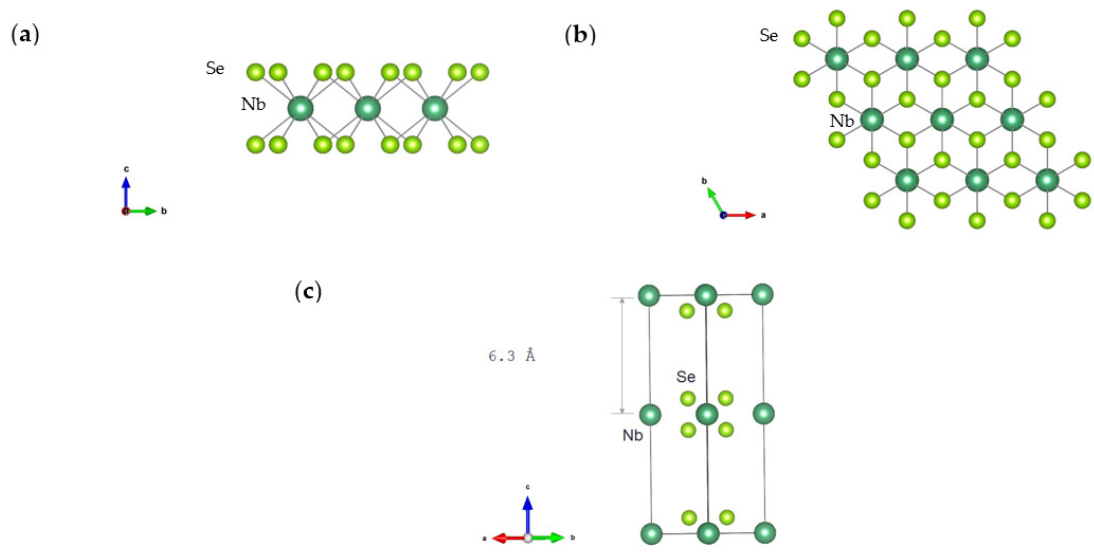
Figure 1. The crystal structure of NbSe 2 in ( a ) Front view, ( b ) Upper view, ( c ) Side view if the bulk NbSe 2 crystal structure to visualize the interlayer distance.